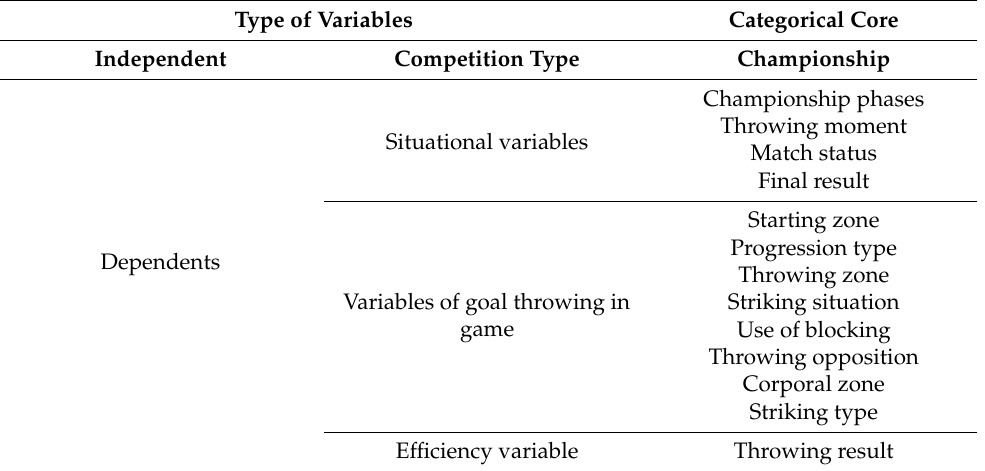
Table 1. Variables involved in Fa5